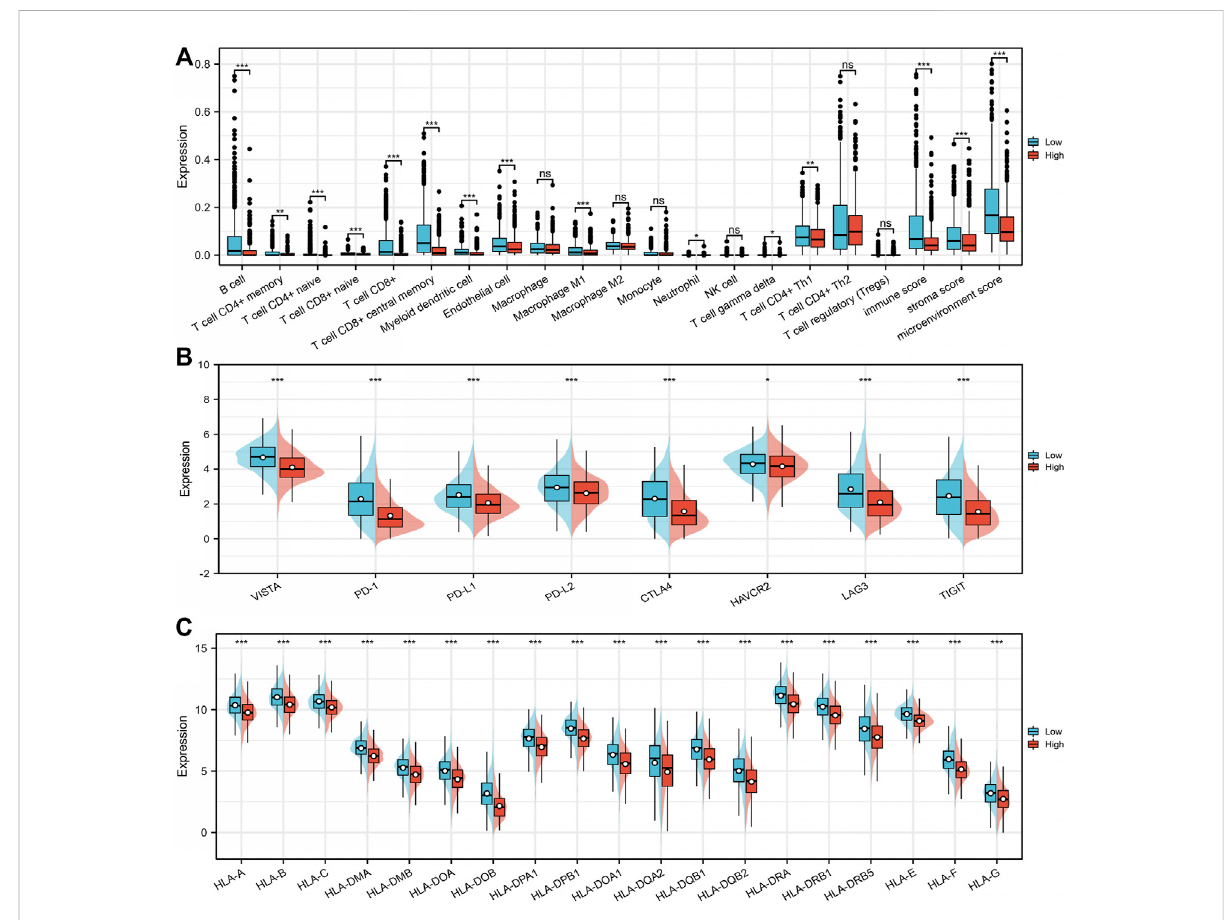
FIGURE 6 Characteristics of the immune microenvironment between low- and high-immunogenic cell death (ICD)-related risk groups in The Cancer Genome Atlas (TCGA) breast invasive cancer (BRCA) cohort. The expression difference of (A) immune cell in fi ltration levels, (B) immune checkpoint genes, and (C) human leukocyte antigen (HLA) genes between ICD-related risk groups. * p < 0.05, ** p < 0.01, and *** p <